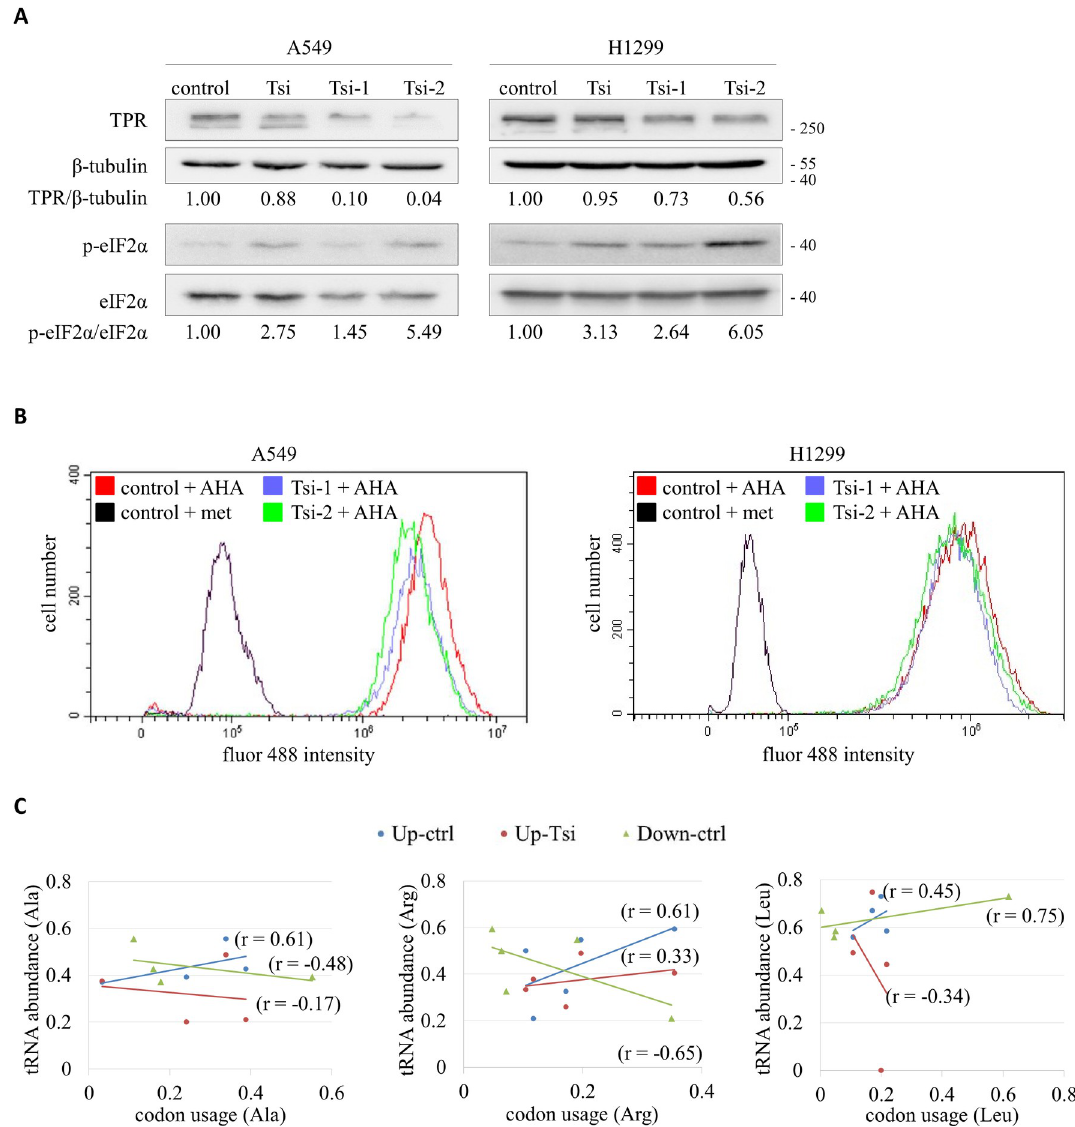
Fig 6. Suppression of protein synthesis by TPR knockdown. (A) Western blot to detect the phosphorylation of eIF2 α . Protein extracts were prepared from A549 and H1299 cells without (control) or with TPR knockdown (Tsi, Tsi-1 and Tsi-2). Specific antibodies were used to detect the cellular levels of TPR, β -tubulin, phosphorylated eIF2 α (p-eIF2 α ) and total eIF2 α . Numbers indicate the ratios of TPR / β -tubulin (top) and p-eIF2 α / eIF2 α (bottom). (B) FUNCAT assay followed by flow cytometry analysis of the fluor 488 signal intensity. A549 and H1299 cells without (control) or with TPR knockdown (Tsi-1 and Tsi-2) were incubated with 4 mM azidohomoalanine (AHA) or methionine (met, as negative control) for 2 hours, and tagged with fluor 488-alkyne for detection. At least 10,000 cells were analyzed for each condition. (C) Correlation of cytoplasmic abundance of tRNA Ala , tRNA Arg and tRNA Leu isoacceptors in control (ctrl) and TPR knockdown (Tsi) A549 cells to codon usage of the top 10 up-regulated (Up) and the 10 most down-regulated (Down) genes in lung cancer tissues with high TPR expression. Cytoplasmic abundance of tRNA was calculated as tRNA cyt = tRNA tot - tRNA nuc , using the data from the tRNA PCR array.